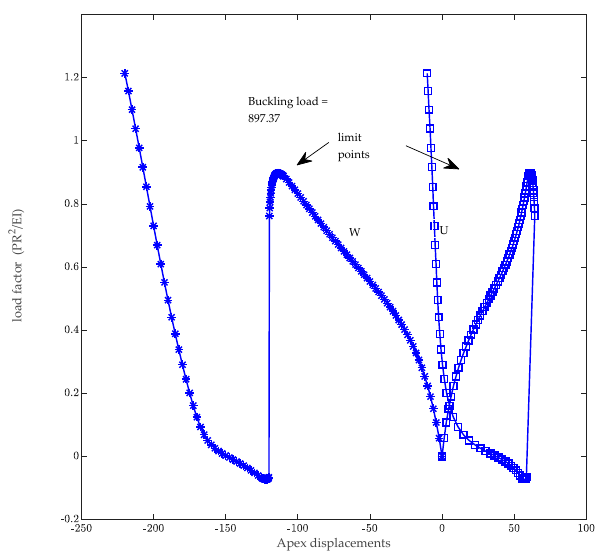
Figure 14. Spatial configurations of a clamped–hinged circular arch subject to a concentrated load up to instability.